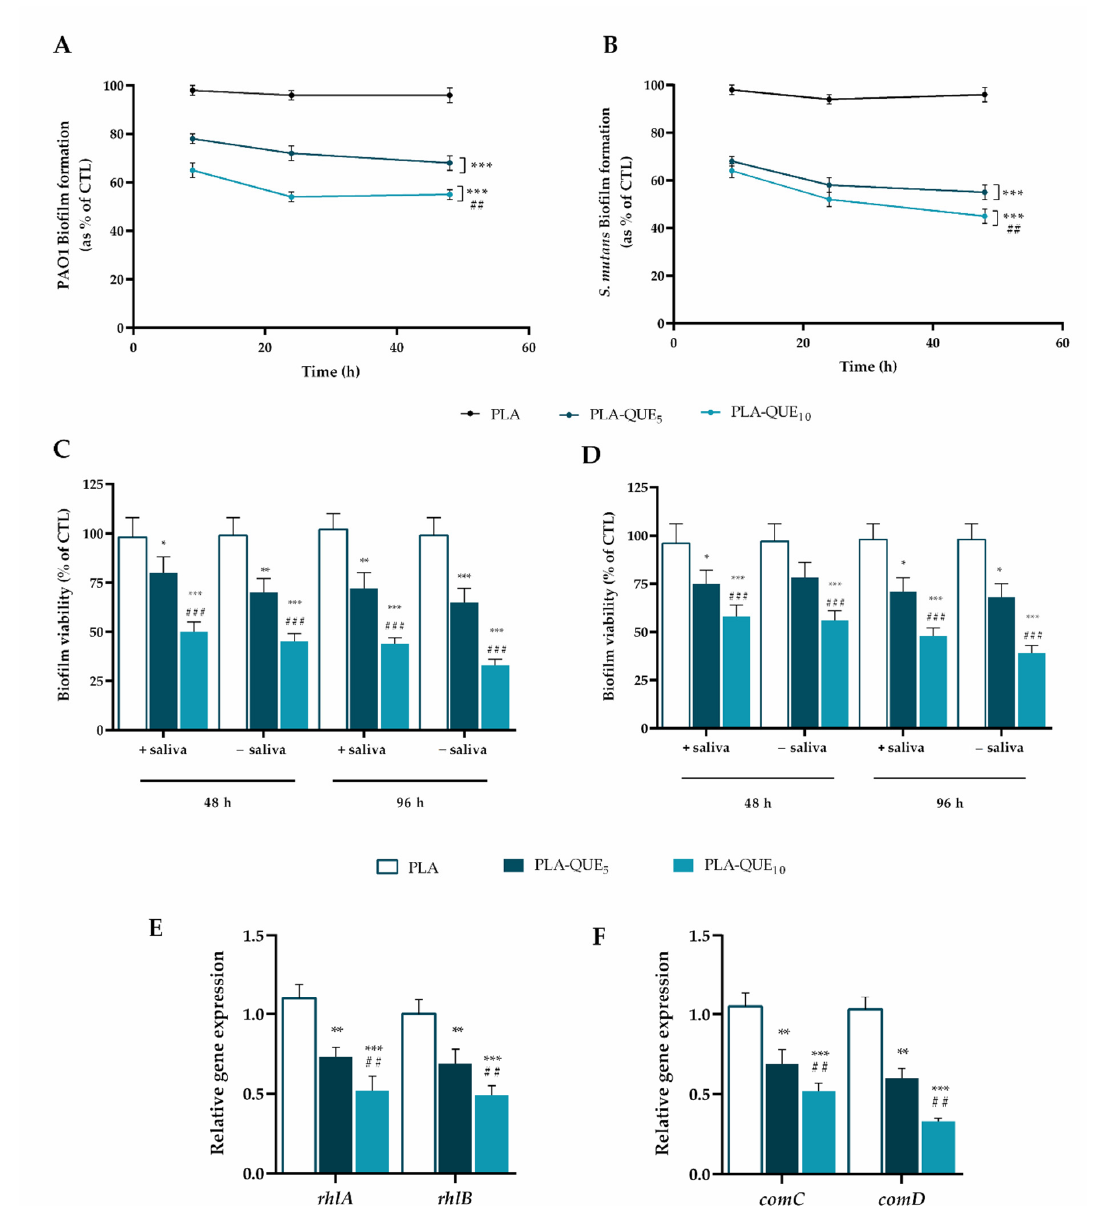
Figure 3. Antibiofilm activity of quercetin-loading membranes. Biofilm formation in a static mode was evaluated by the CV assay, after 6, 12 and 24 h of incubation at 37 °C in the presence of PAO1 ( A ) and S. mutans ( B ) measuring the absorbance at 570 nm (OD570) in a microplate reader. Bacterial growth in the presence of PLA was used as control. Biofilm formation in a dynamic mode was evaluated by the MTT assay, simulating or not simulating the formation of salivary pellicle, after 48 and 96 h of incubation at 37 °C in the presence of PAO1 ( C ) and S. mutans ( D ). The absorbance of each well was read at 510 nm. Biofilm formation was reported as a percentage in comparison with the maximum amount of biofilm produced by PAO1 and S. mutans grown in the presence of PLA (positive controls). Relative RNA expression of rhlA and rhlB in PAO1 ( E ); relative RNA expression of comC and comD in S. mutans ( F ). Different gene expression levels were normalized to the level of 16sRNA gene transcripts. Gene expression levels of biofilm formed in the presence of PLA were used as control. For each sample, six different experiments were conducted, and the results are expressed as the mean of the values obtained (mean ± SD). Statistically significant variations: * p < 0.05, ** p < 0.01 and *** p < 0.001 versus PLA; ## p < 0.01 and ### p < 0.001 versus PLA-QUE 5 .